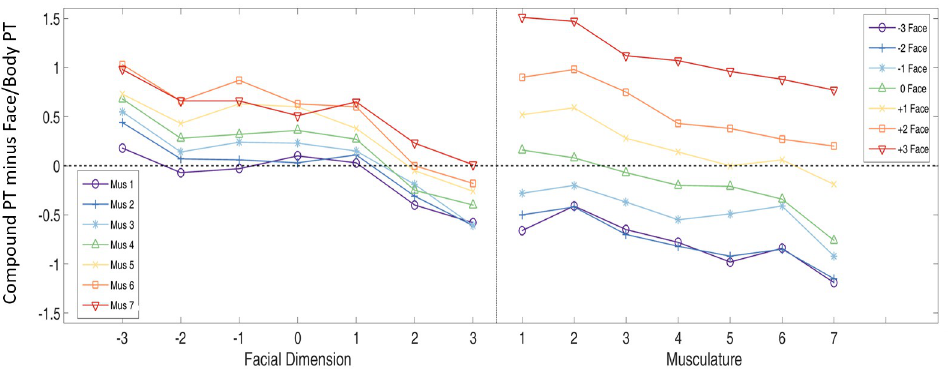
Fig 5. Plots illustrating the disparity in perceived threat (PT) for compound stimuli minus the face-only stimuli (left) and the disparity in perceived threat for the compound stimuli minus the body-only stimuli (right). In all conditions, the slopes of the best fitting line to the data were significantly different from 0 ( p < .05), indicating the significant interaction of face and body